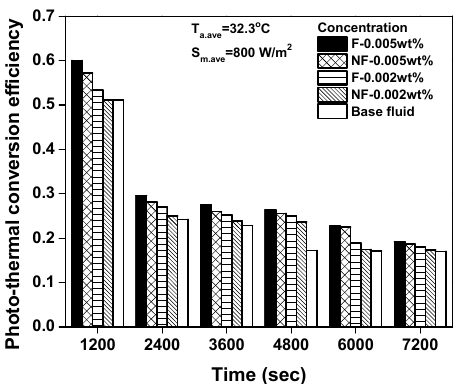
Figure 15. Comparison of photo-thermal energy conversion efficiency for different MWCNT nanofluid with time.